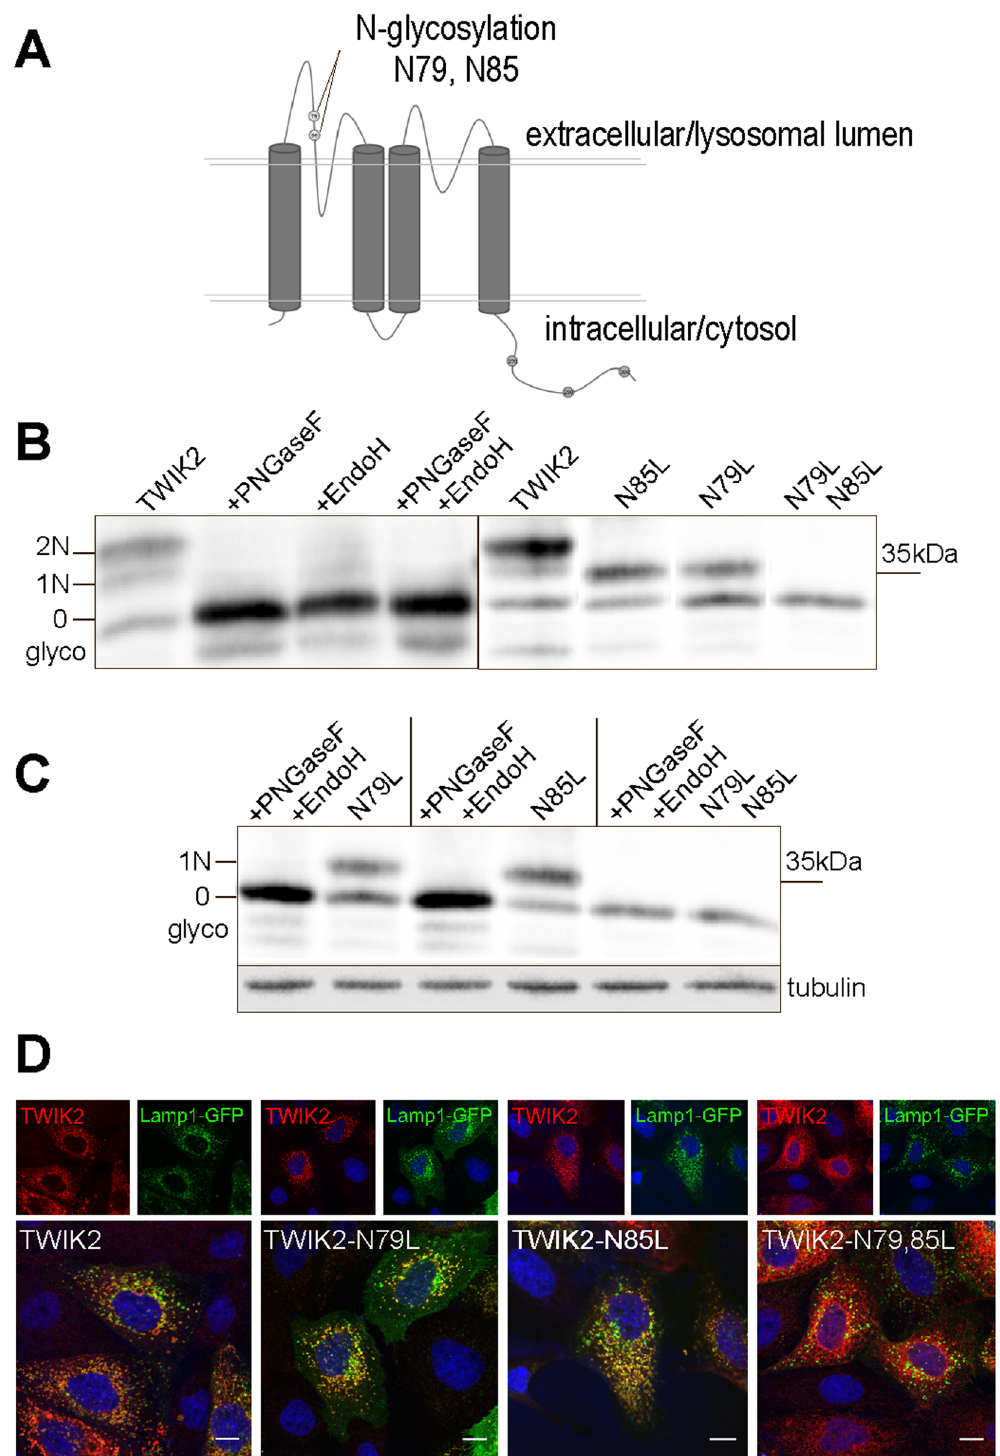
Figure 7. Glycosylation of rat TWIK2 in the M1-P1 extracellular/lumenal loop. ( A ) TWIK2 membrane topology and localization of the N-glycosylation sites. ( B ) TWIK2 deglycosylation. Protein lysates from COS cells expressing TWIK2 were incubated with PNGaseF and/or EndoH. The blot images have been cropped, only bands corresponding to glycosylated and deglycosylated TWIK2 isoforms are shown. ( C ) Mutation of the glycosylation sites (N to L) has the same effect as incubation with PNGaseF and EndoH. The blot images have been cropped, only bands corresponding to glycosylated and deglycosylated TWIK2 isoforms are shown. ( D ) Immunolabelling in MDCK transfected cells. TWIK2 N 79 L and TWIK2 N 85 L have a lysosomal distribution whereas TWIK2 N 79 LN 85 L is detected in the endoplasmic reticulum. Scale bar: 10 µ